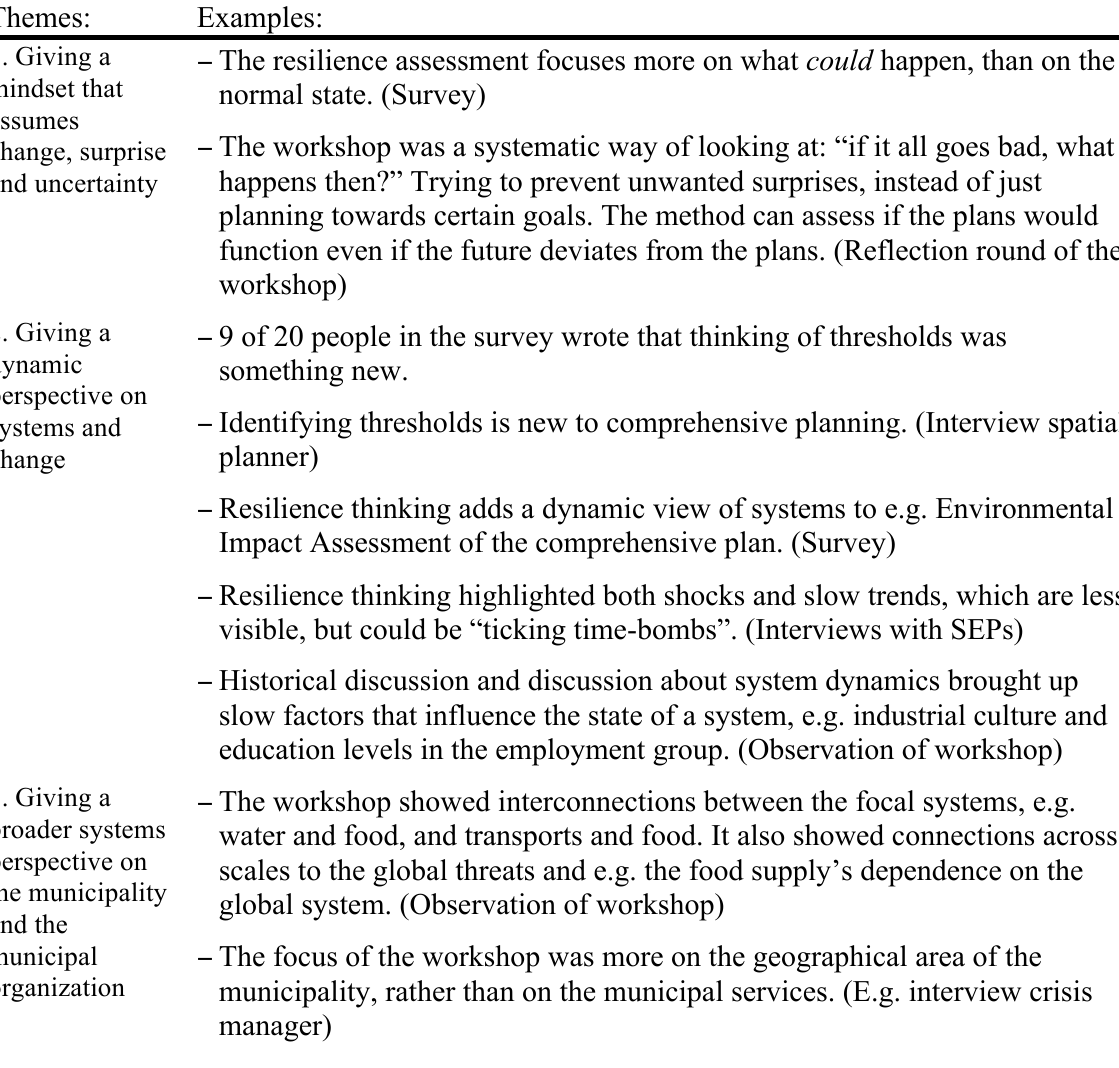
Table A5.1 . Contributions of the resilience assessment in Eskilstuna to municipal planning, presented with